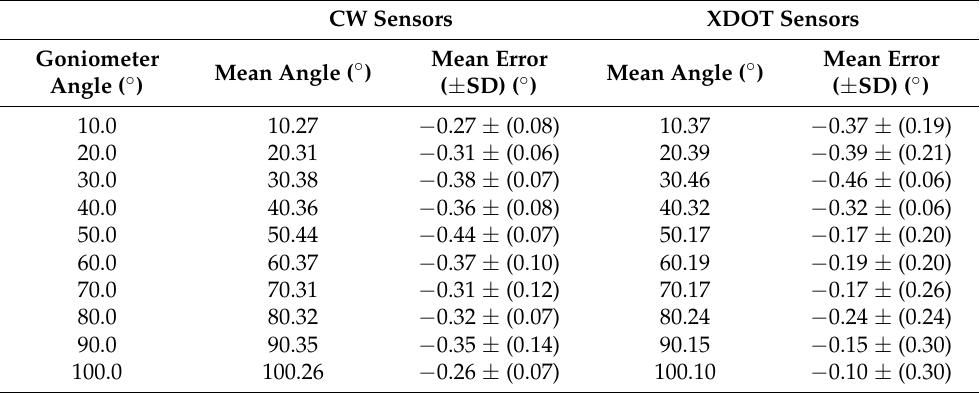
Table 2. Accuracy of the proposed Custom Wearable (CW) sensors set on an artificial elbow joint. Comparison with golden measurements taken from a digital goniometer set in steps of 10 ◦